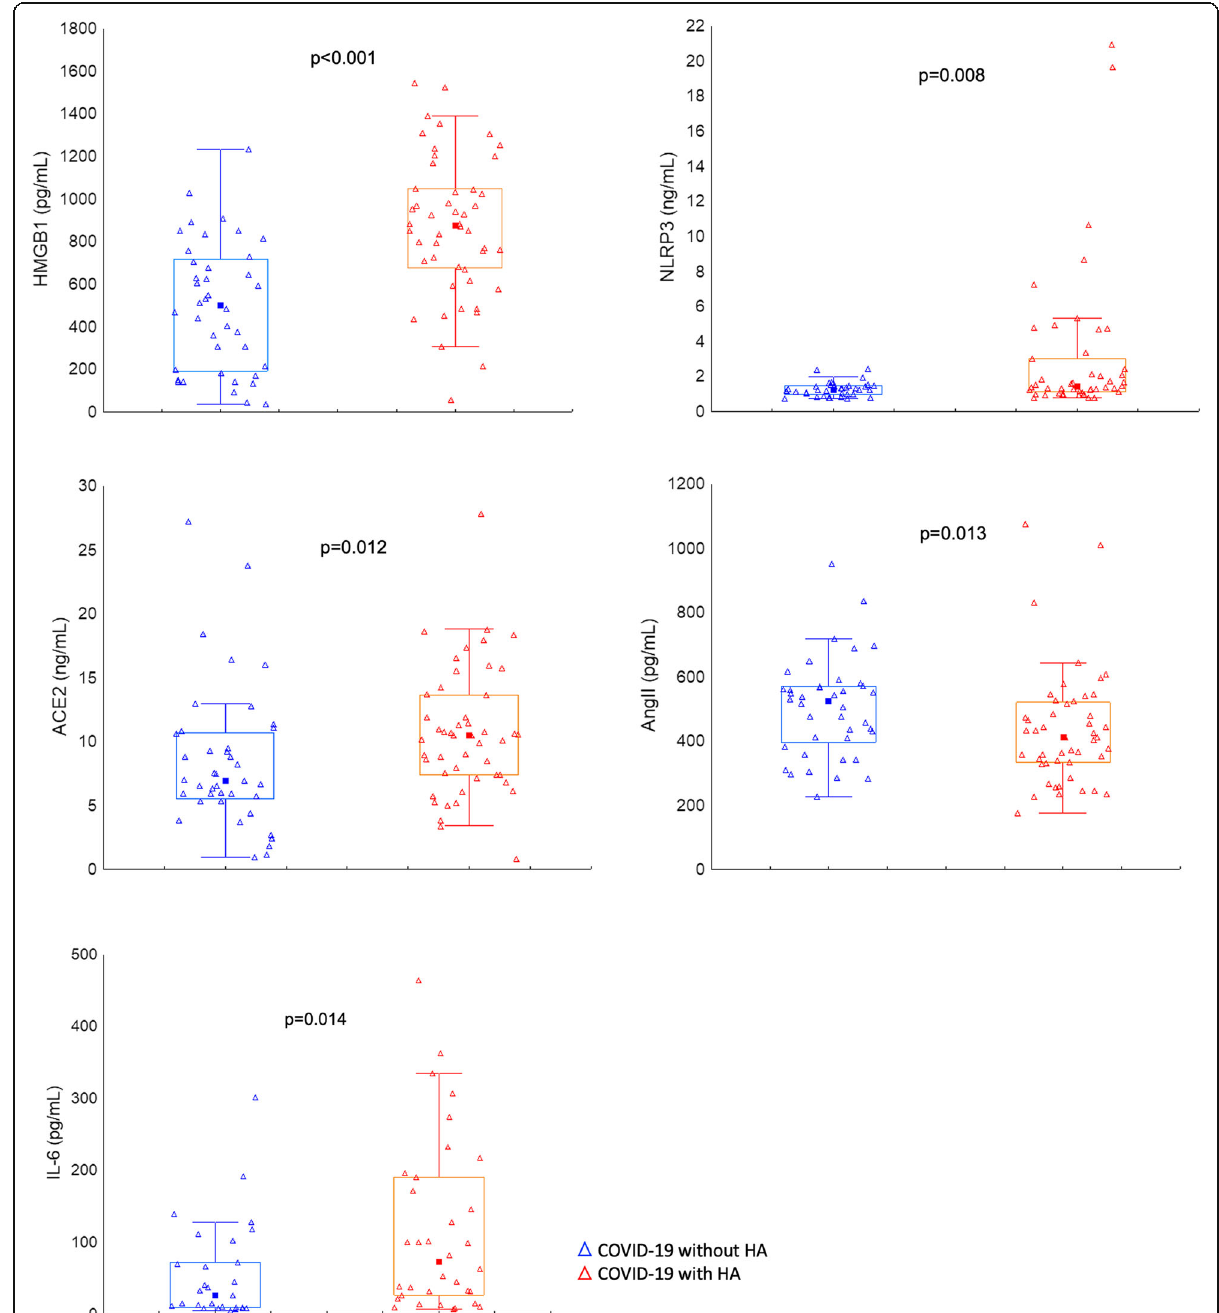
Fig. 1 Serum levels of inflammatory molecules at hospital admission in COVID-19 patients. HMGB1, NLRP3, ACE2, IL-6 levels were significantly increased in COVID-19 patients with headache ( n = 48) compared to COVID-19 patients without headache ( n = 40). Angiotensin II level was significantly decreased in COVID-19 patients with